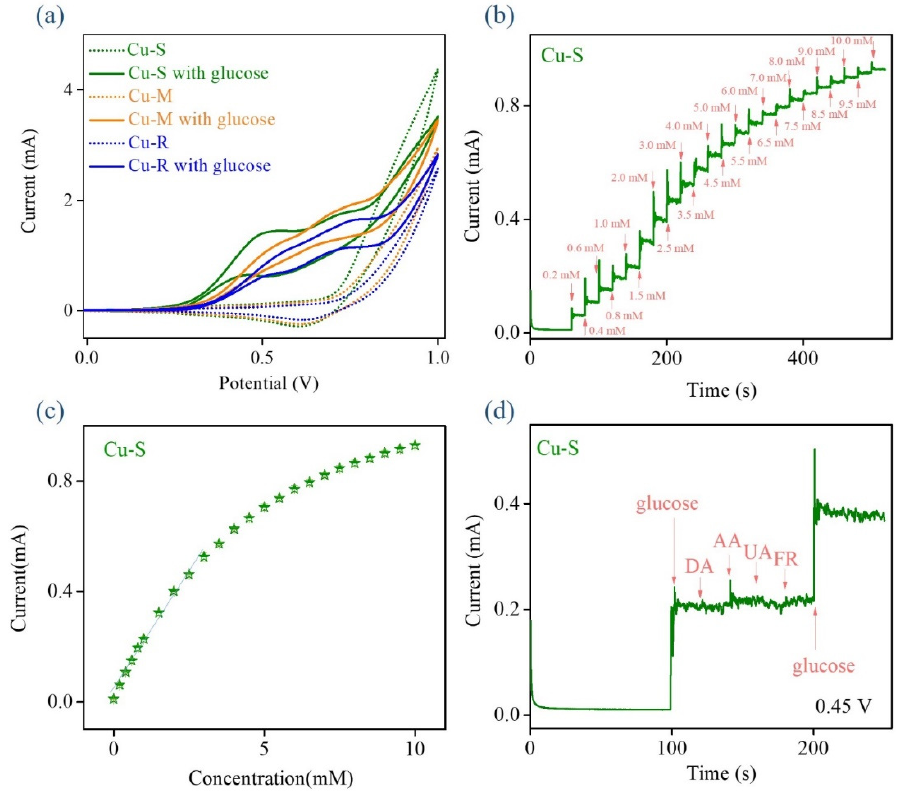
Figure 5. ( a ) CV curves of Cu-R, Cu-M, and Cu-S in 0.1 M NaOH in the absence (dashed lines) and presence (solid lines) of 10 mM glucose at a scan rate of 50 mV s − 1 . ( b ) Amperometry of Cu-S in 0.1 M NaOH with successive addition of various glucose concentrations at applying voltage +0.45 V. ( c ) Corresponding calibration plot of the response current versus glucose concentration. ( d ) Interference test of Cu-S in 0.1 M NaOH at applying voltage +0.45 V.